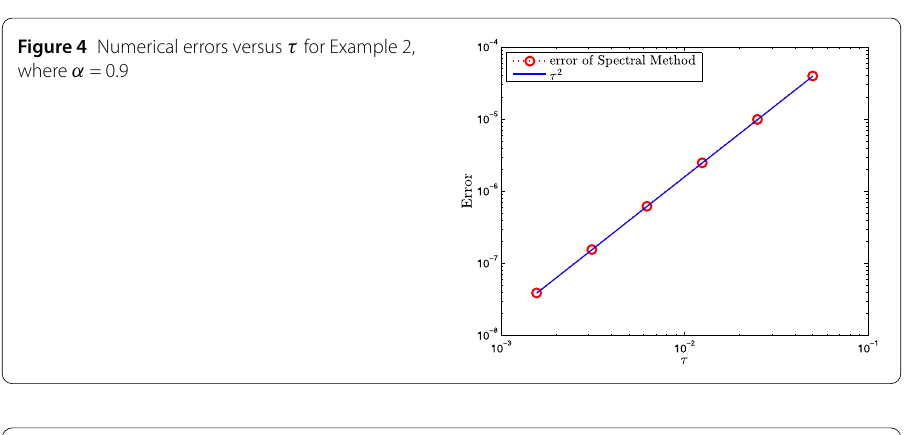
Figure 5 Numerical errors versus polynomial degree N for Example 2, where α =